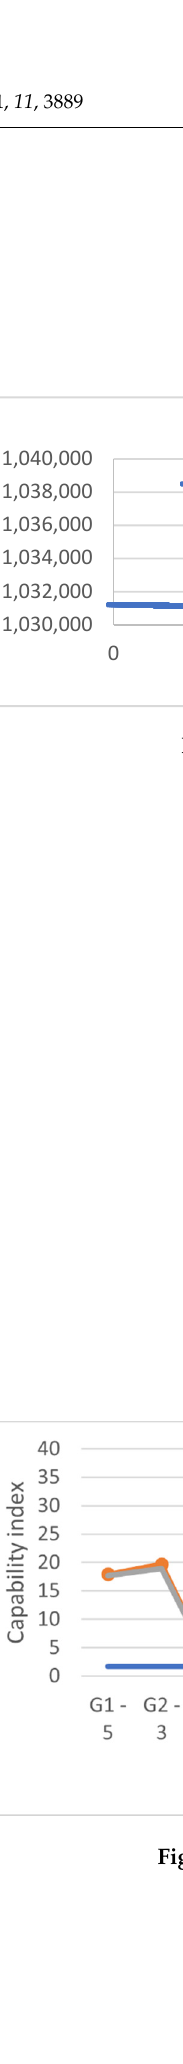
Figure 15. Plot of capability index for all DIMs based on sizes.